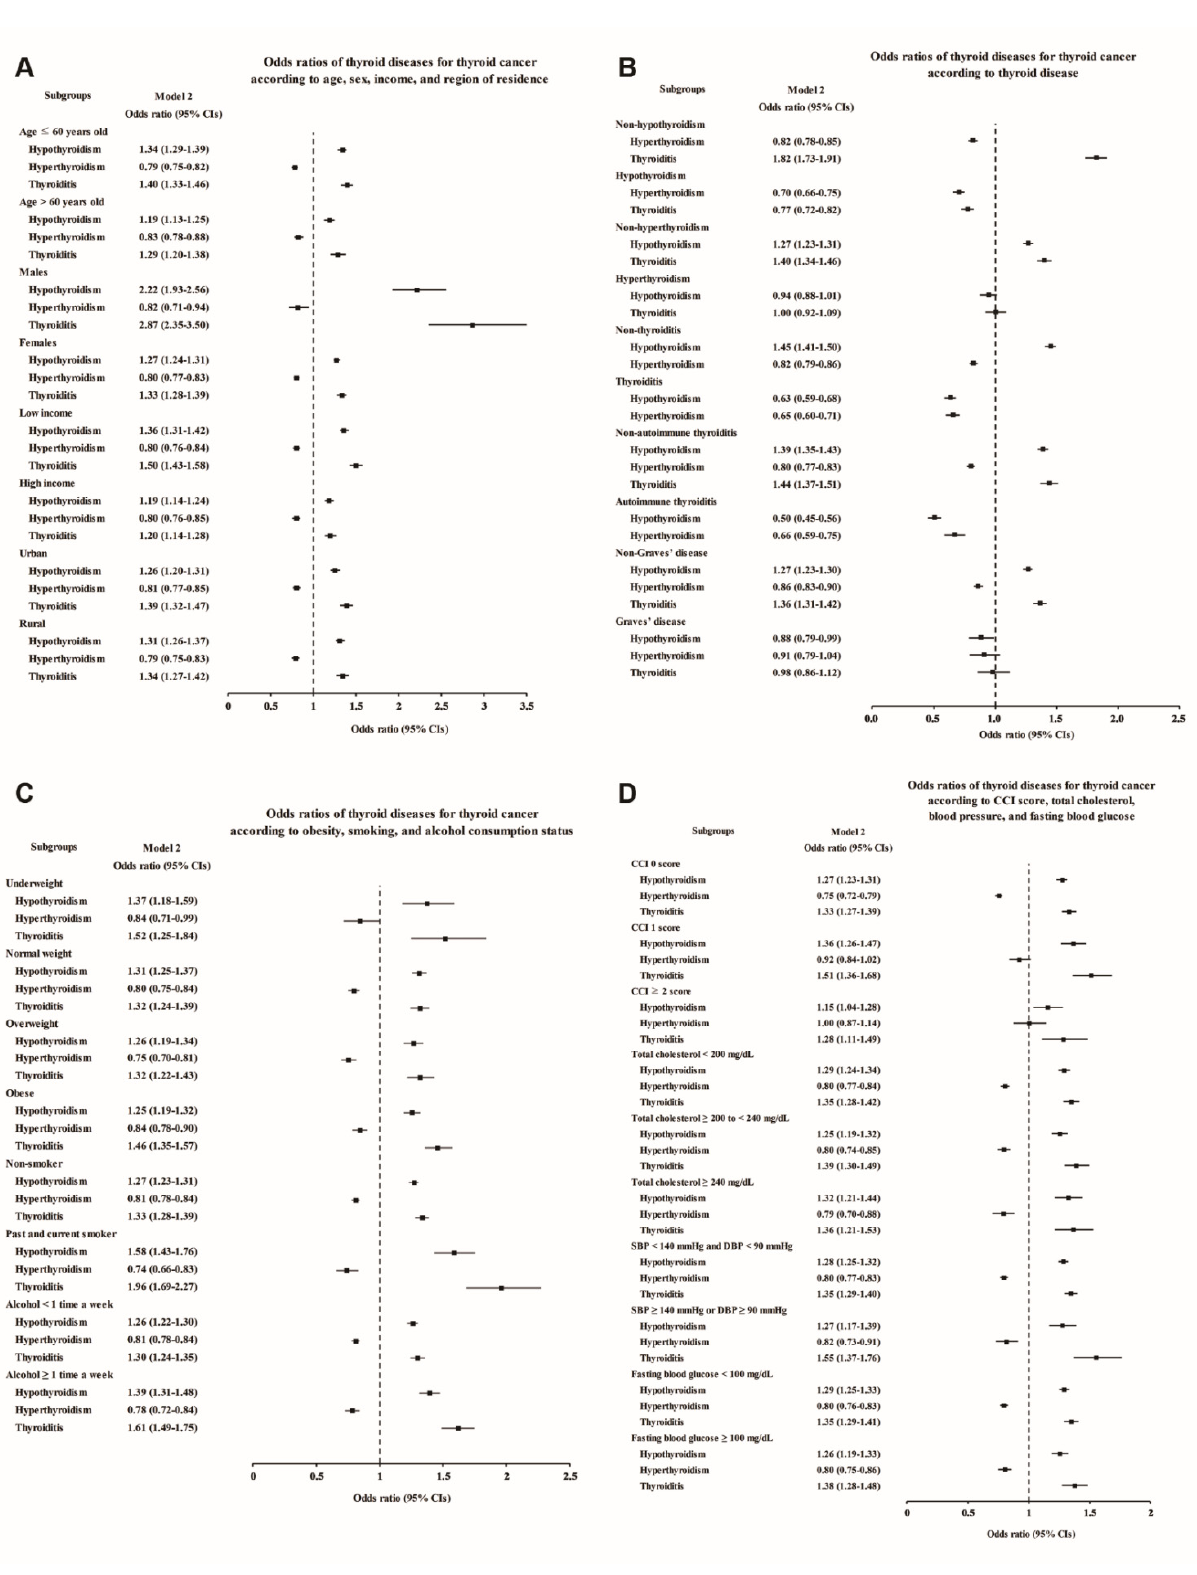
Figure 3. Adjusted odds ratios for thyroid cancer in the subgroup analyses of Study II. The subgroup analyses by ( A ) age, sex, income, and region of residence, ( B ) hypothyroidism, hyperthyroidism, thyroiditis, autoimmune thyroiditis, and Graves’ disease, ( C ) obesity by BMI, smoking status, and frequency of alcohol intake, and ( D ) CCI, total cholesterol, SBP, DBP, and fasting blood glucose. CCI, Charlson comorbidity index; SBP, systolic blood pressure; DBP, diastolic blood